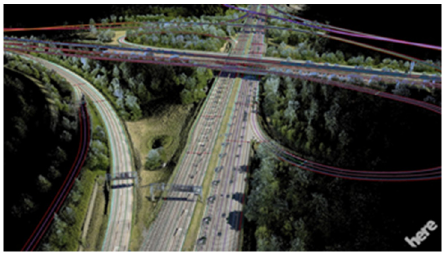
Figure 4. An image from a high definition map (https://here.com/) [11].